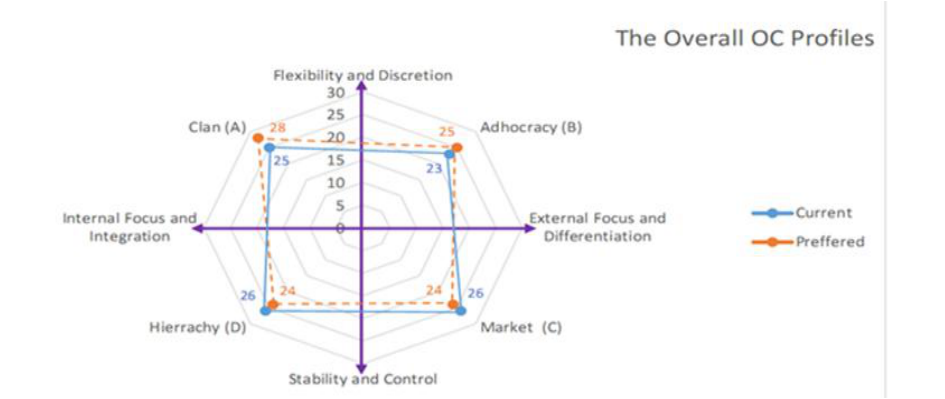
Figure 10. Radar diagram of dimension of overall organizational culture